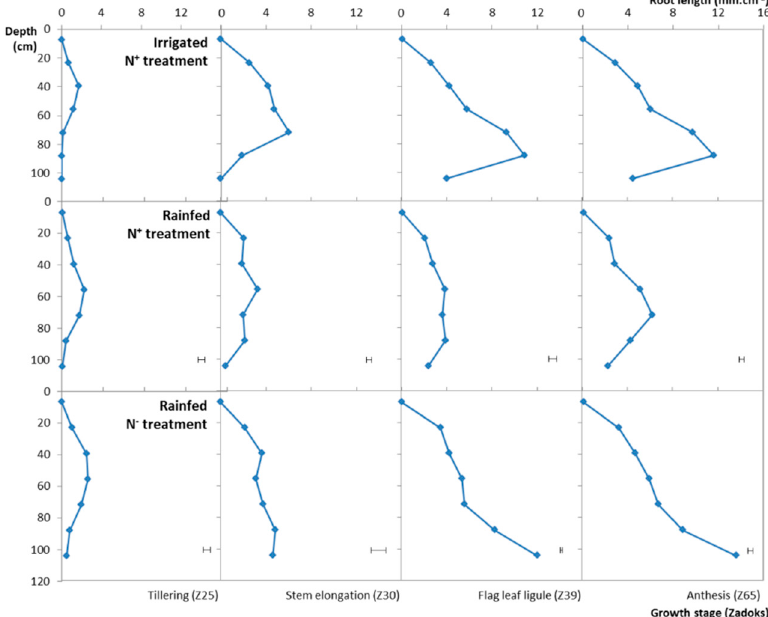
Figure 6. Treatments effects (Irrigation, Nitrogen) on the root length surface density profiles’ dynamic of the Apache bread wheat. The mean RLSD profiles (mm cm − 2 ) of Apache wheat cultivar are shown at tillering (Z25), stem elongations (Z30), flag leaf ligule (Z39) and anthesis (Z65) stages, with bars representing the median variation of RLSD. Fertilised plots in rainfed conditions (I – N + ) display shallow root profiles, whereas I − N − plots exhibit a root system that developed deeper. The latter yielded 1.9 t ha − 1 more than its counterpart under I – N+ conditions.